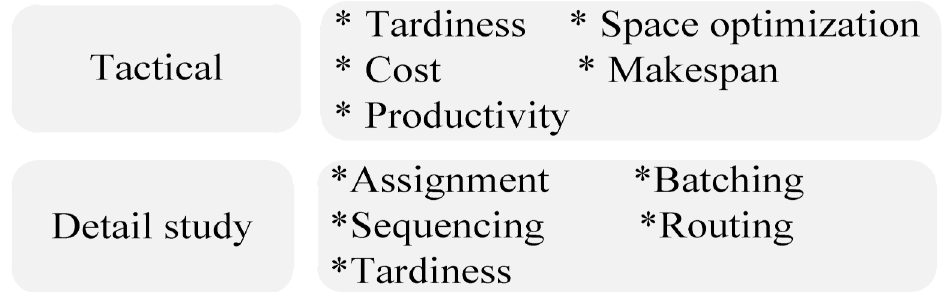
Figure 9. Study areas of the investigated articles.